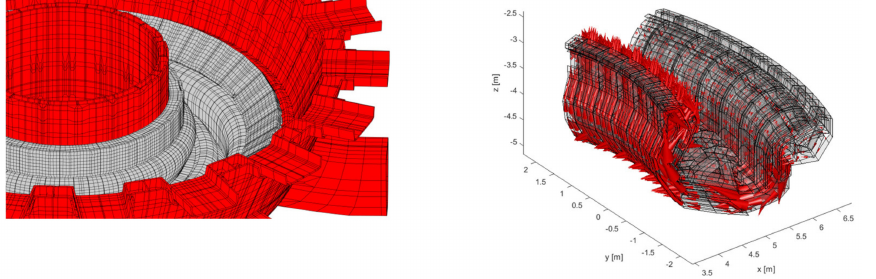
Figure 3. A common part of the finite element mesh for VV, blanket, and divertor used with all presented below models of bridges for the anti-symmetric halo current component (models #1, 2, 3, and 4), and an example of halo current density pattern obtained in the post-processing of VDE (that means vectors of currents are shown here for a symmetric plasma event, not for AVDE yet).